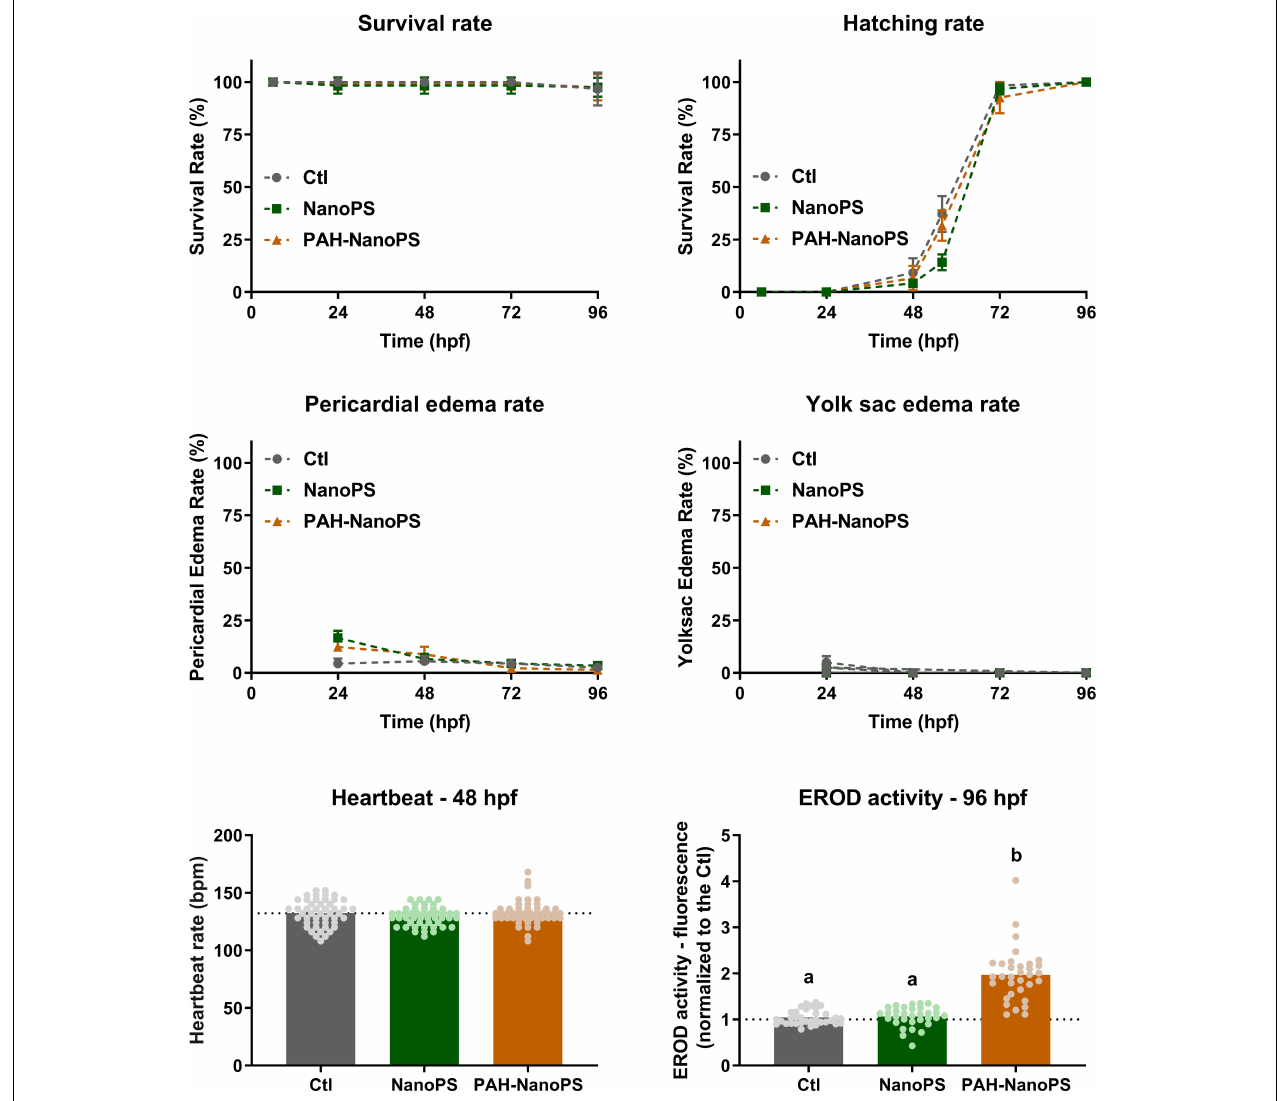
FIGURE 3 | Morphological screening and EROD activity of zebrafish embryos and larvae. Animals were exposed at 6 h post-fertilization (hpf) to 1 ppm polystyrene nanoparticles (NanoPS) or 1 ppm polystyrene nanoparticles with PAHs sorbed to their surface (PAH-NanoPS) (please see Figure 1 and section “Sorption of PAHs to the surface of NanoPS” for further details). Survival, hatching, yolk sac edema, and pericardial edema were assessed throughout the exposure, while the heartbeat was assessed at 48 hpf and EROD activity was analyzed in vivo at 96 hpf. Data are presented as average ± standard deviation ( n = 9–12), except for heartbeat ( n = 48) and EROD activity ( n = 32–35) which are shown as average and scatter plot of individual replicates. The dotted line represents the average of the control group. Survival rate was analyzed by Mantel-Cox log-rank test; hatching, yolk sac edema, and pericardial edema rates were individually analyzed at each time point by one-way ANOVA followed by Tukey’s post-hoc or Kruskal-Wallis followed by Dunn’s post-hoc ; heartbeat was analyzed by one-way ANOVA followed by Tukey’s post-hoc . Groups not sharing letters are statistically different ( p <